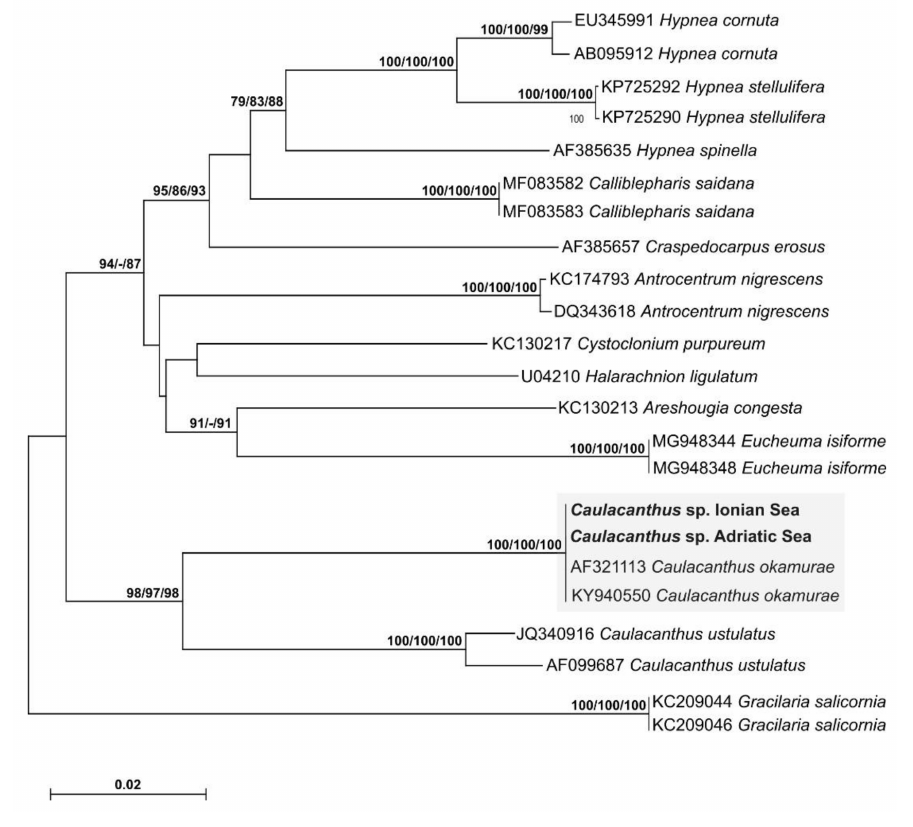
Figure 2. Phylogenetic reconstruction inferred from rbc L sequences. The numbers near the nodes indicate bootstrap values ( > 50) (NJ / MP / ML). The sequences obtained in this study are indicated in boldface font. The clade including C. okamurae sequences is highlighted in grey